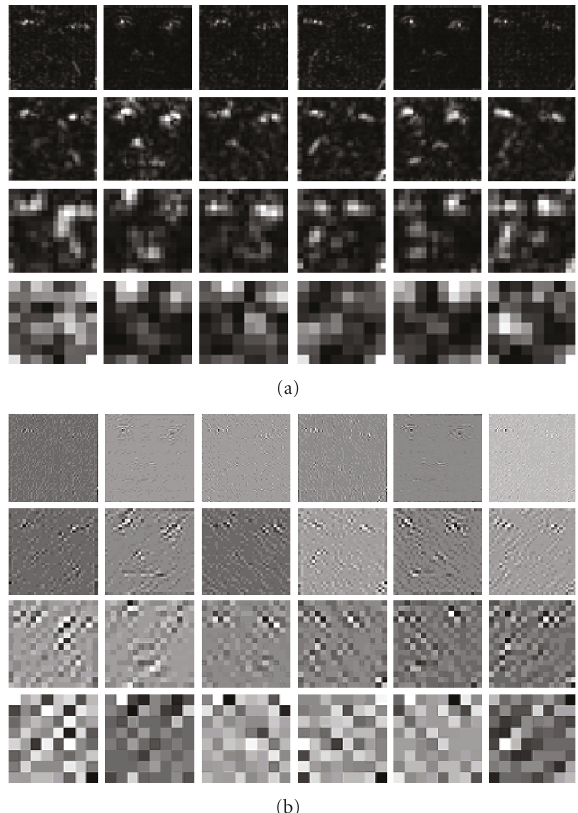
Figure 10: ST-CWT transformation of a sample image (top left face in Figure 12). (a) The magnitude of the transformation. (b) The real part of the transformation.